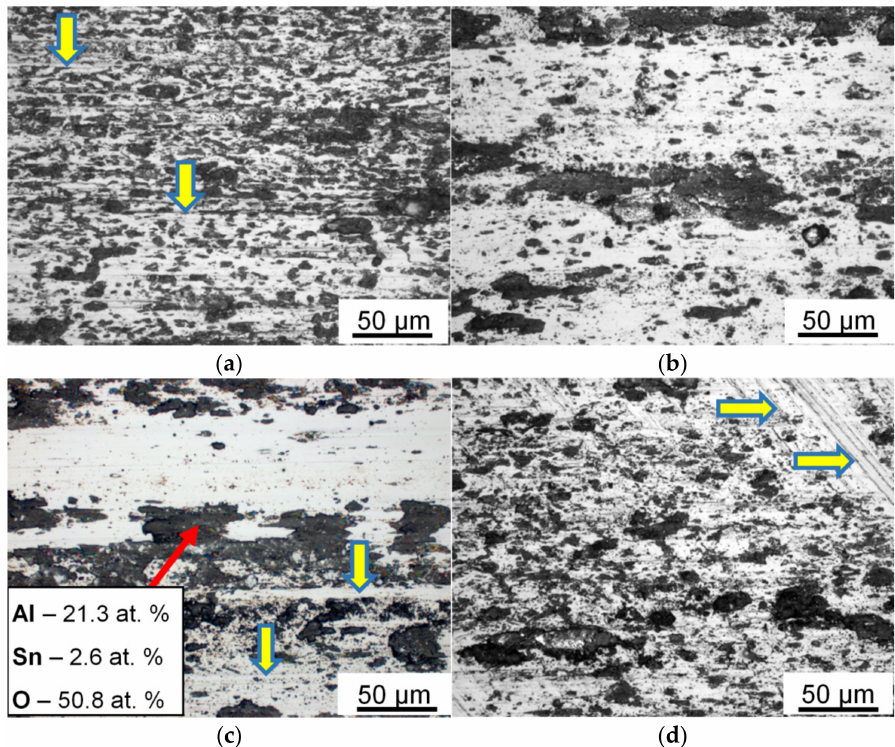
Figure 5. Optical images of the friction track surface on steel counterbody after dry frictional contact with HP-ed (Al–10Zn)–40Sn composite sample. P = 5 MPa ( a – c ) and P = 1 MPa ( d ). V , m/s: 0.9 ( a ); 0.3 ( b ); 0.6 ( c , d ). Traces of the preliminary processing of the counterbody surface are shown by horizontal arrows, and grooves formed on the friction track are shown by vertical